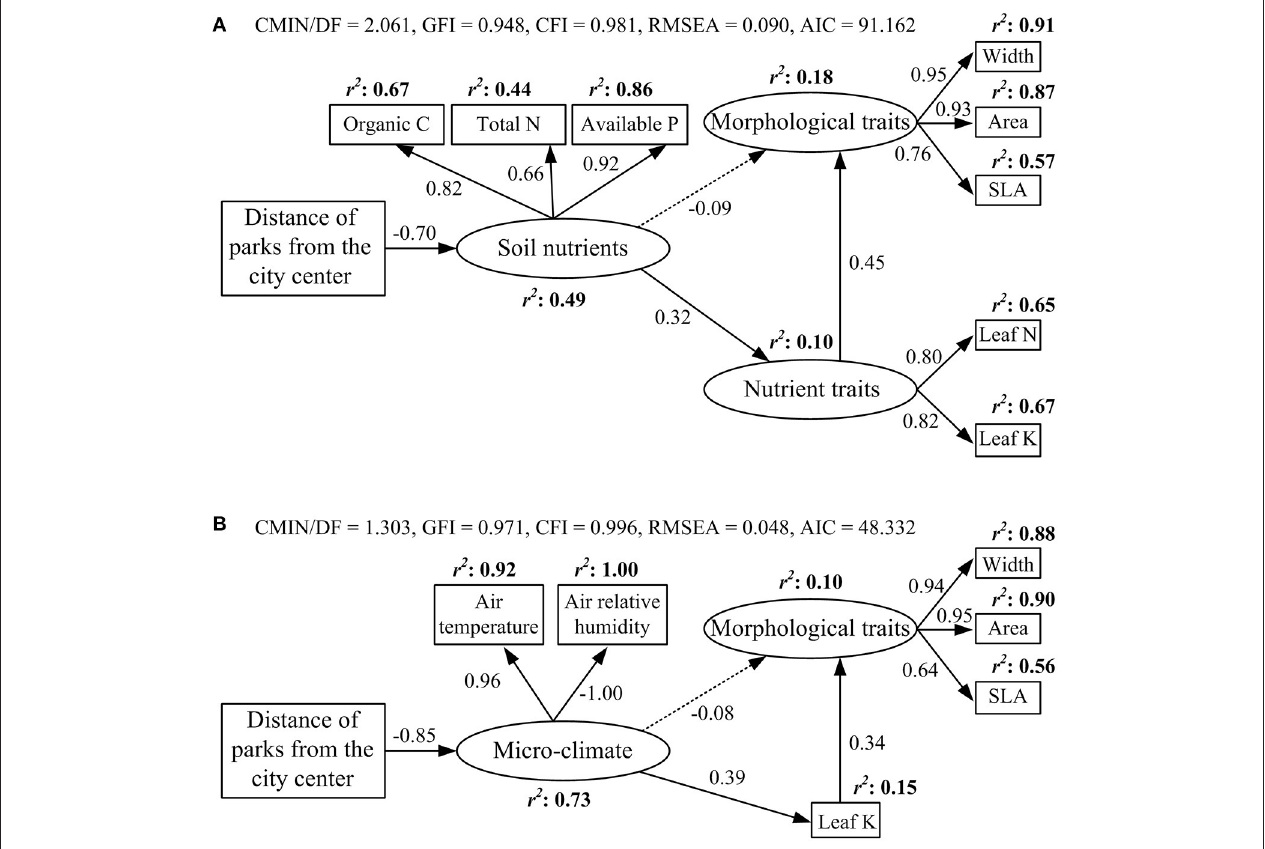
FIGURE 3 | Effects of (A) soil nutrients and (B) micro-climate on leaf morphological and nutrient traits based on the structural equation model. Solid and dashed arrows indicate significant and insignificant effects, respectively ( p < 0.05). Values on arrows indicate standardized regression weights.